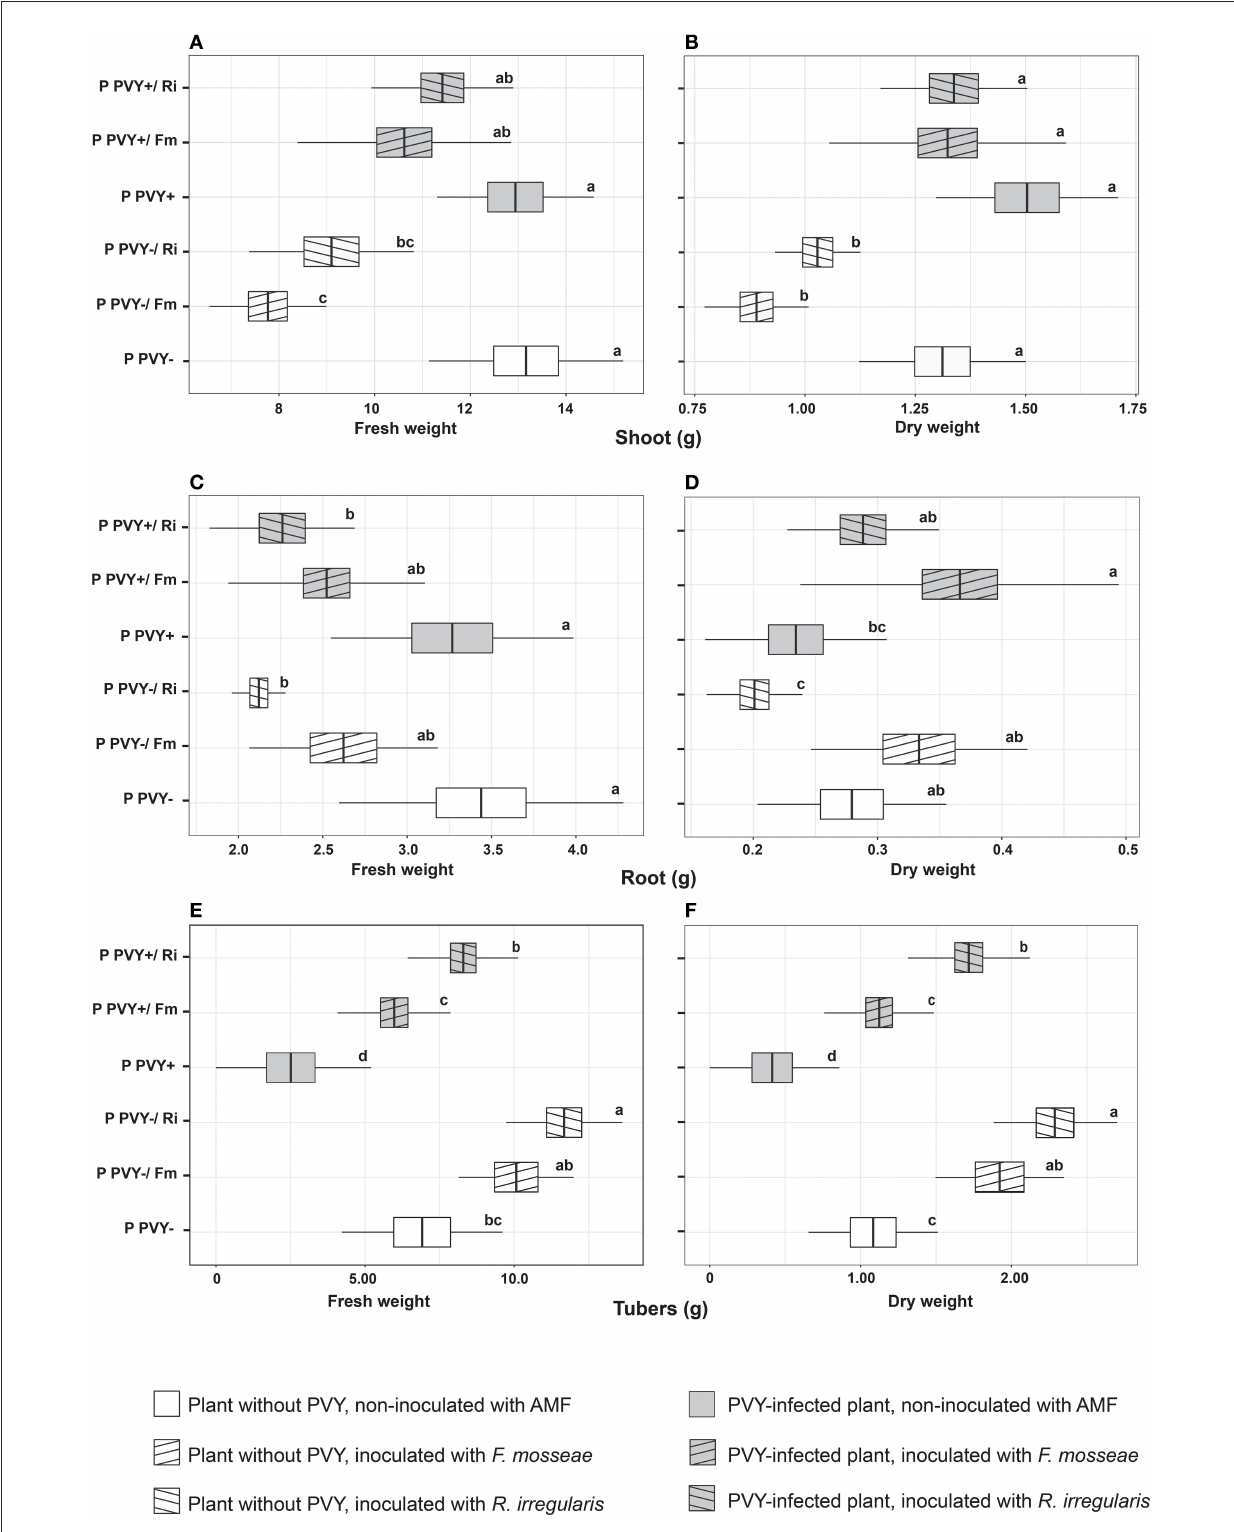
FIGURE3 The combined effect of AMF inoculation and PVY infection on growth parameters of potato shoots (A, B) , roots (C, D) , and tubers (E, F) . The statistically significant differences are marked with letters. The same letters indicate no significant differences ( p >